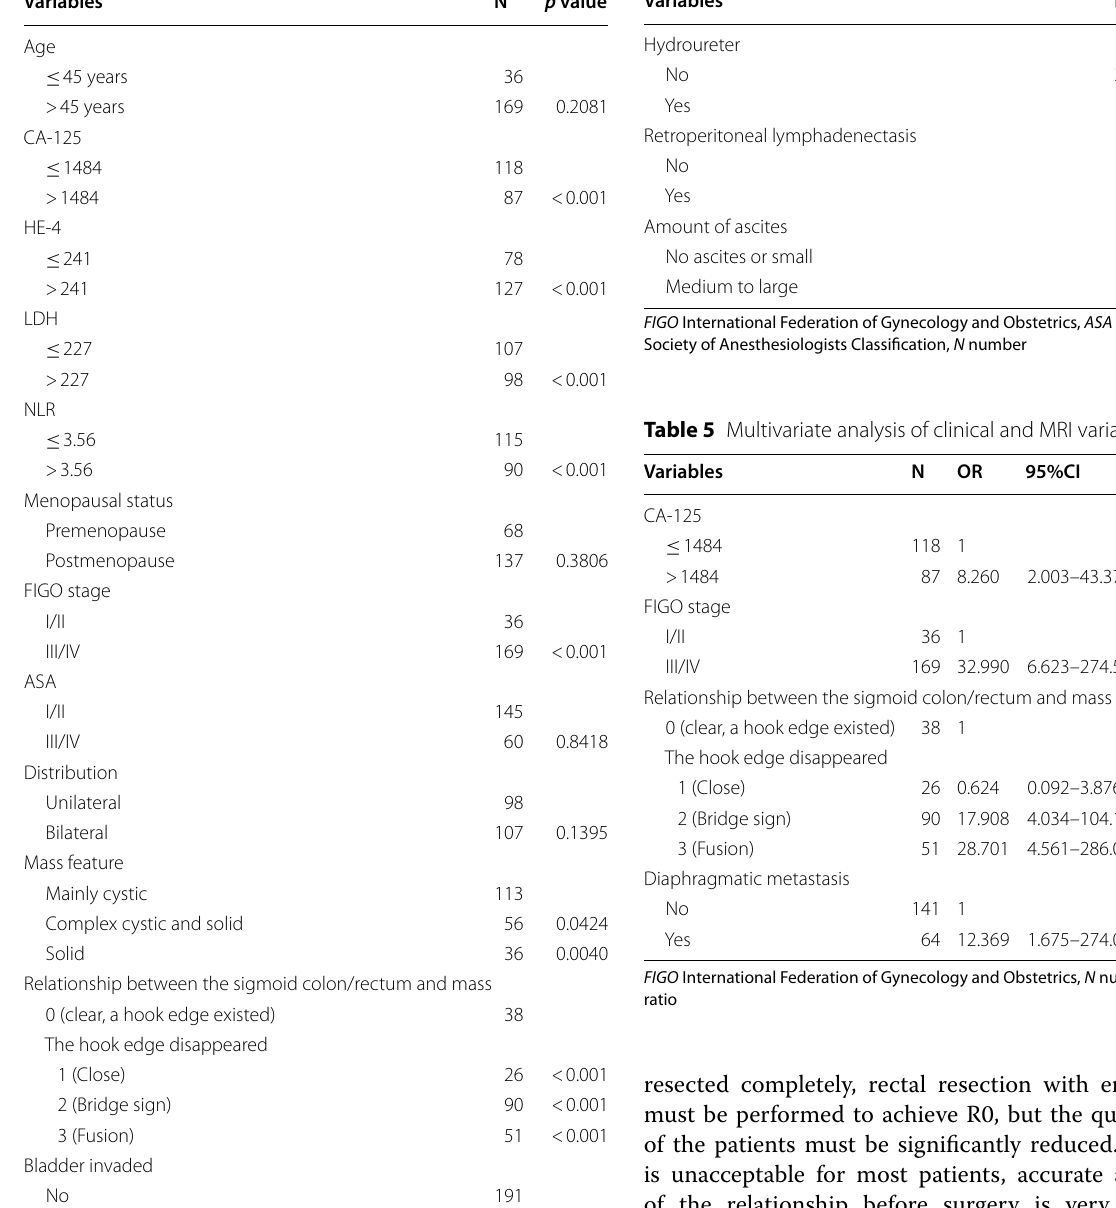
Table 4 Univariate analysis of clinical and MRI variables